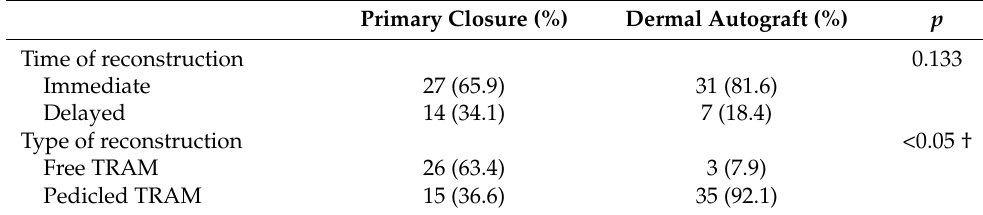
Table 2. Operative characteristics.